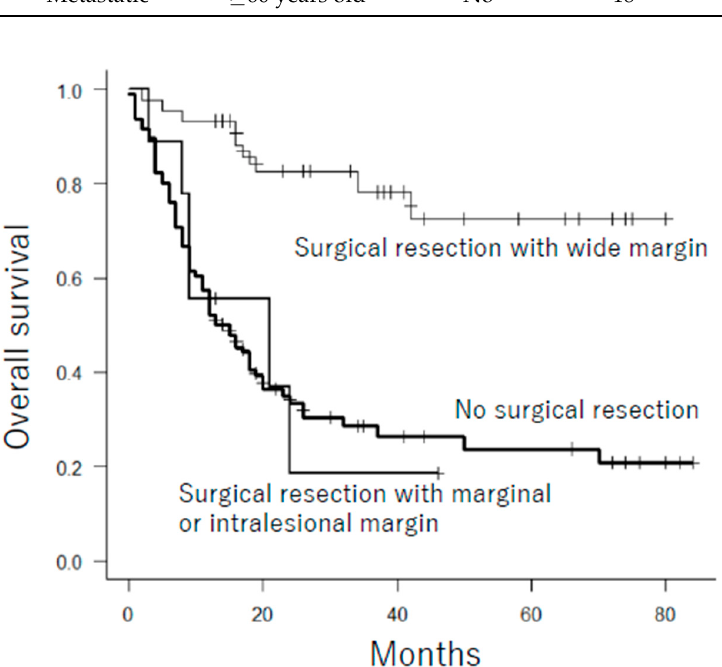
Figure 5. Overall survival for patients with pelvic osteosarcoma according to surgical margin. Patients who underwent wide resection had a significantly better prognosis than patients who underwent marginal or intralesional resection and patients treated without surgical resection ( p < 0.001).